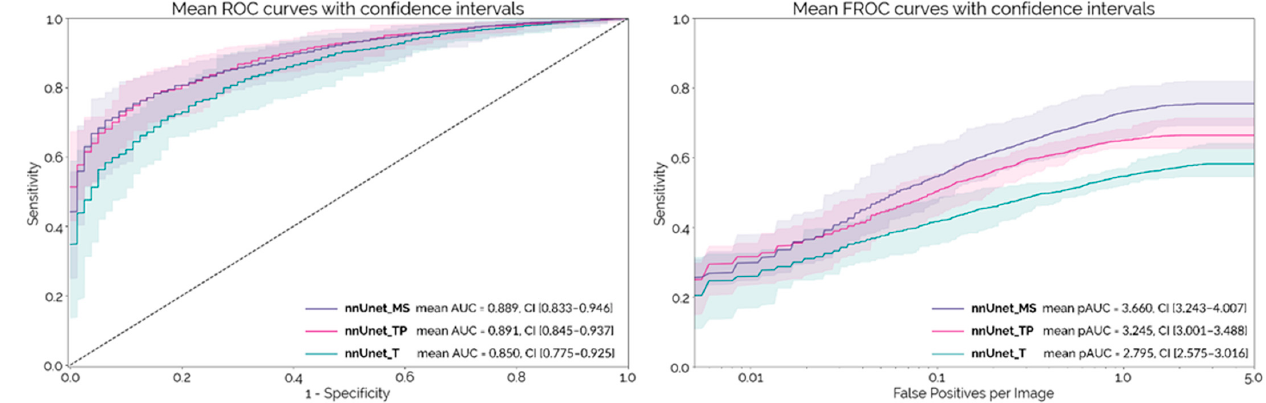
Figure 2. Mean ROC and FROC curves with respective confidence intervals for the external test set.